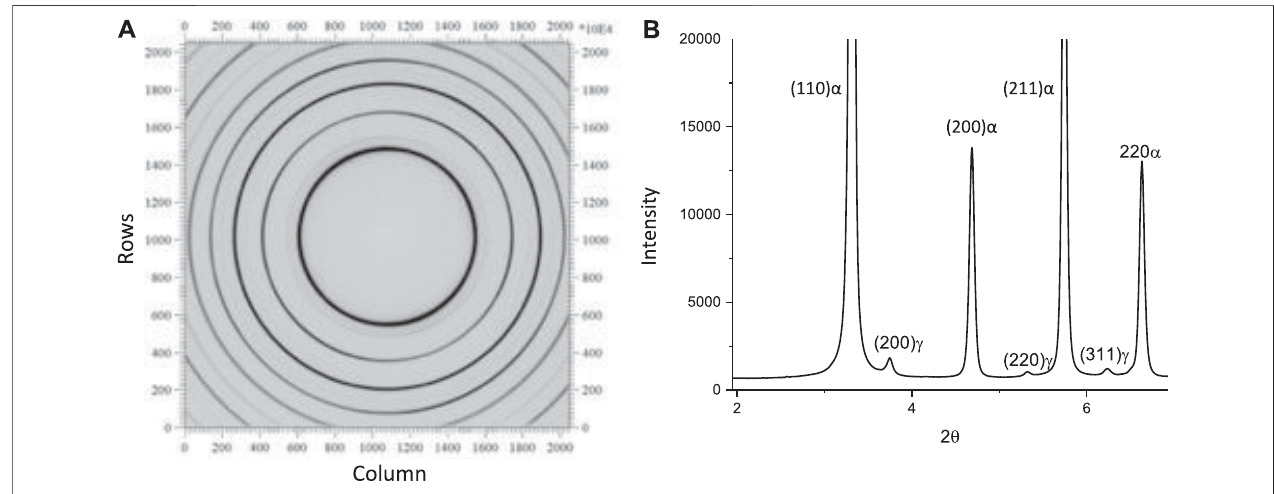
FIGURE 3 | Debye rings recorded on the detector at room temperature before thermal processing of the sample (A) and the corresponding diffraction spectrum from the integrated intensity of the Debye rings over the 360-degree range of β plotted relative to 2 θ position (B) ; ferrite ( α ) and austenite ( γ ) peaks are identi fi ed in the